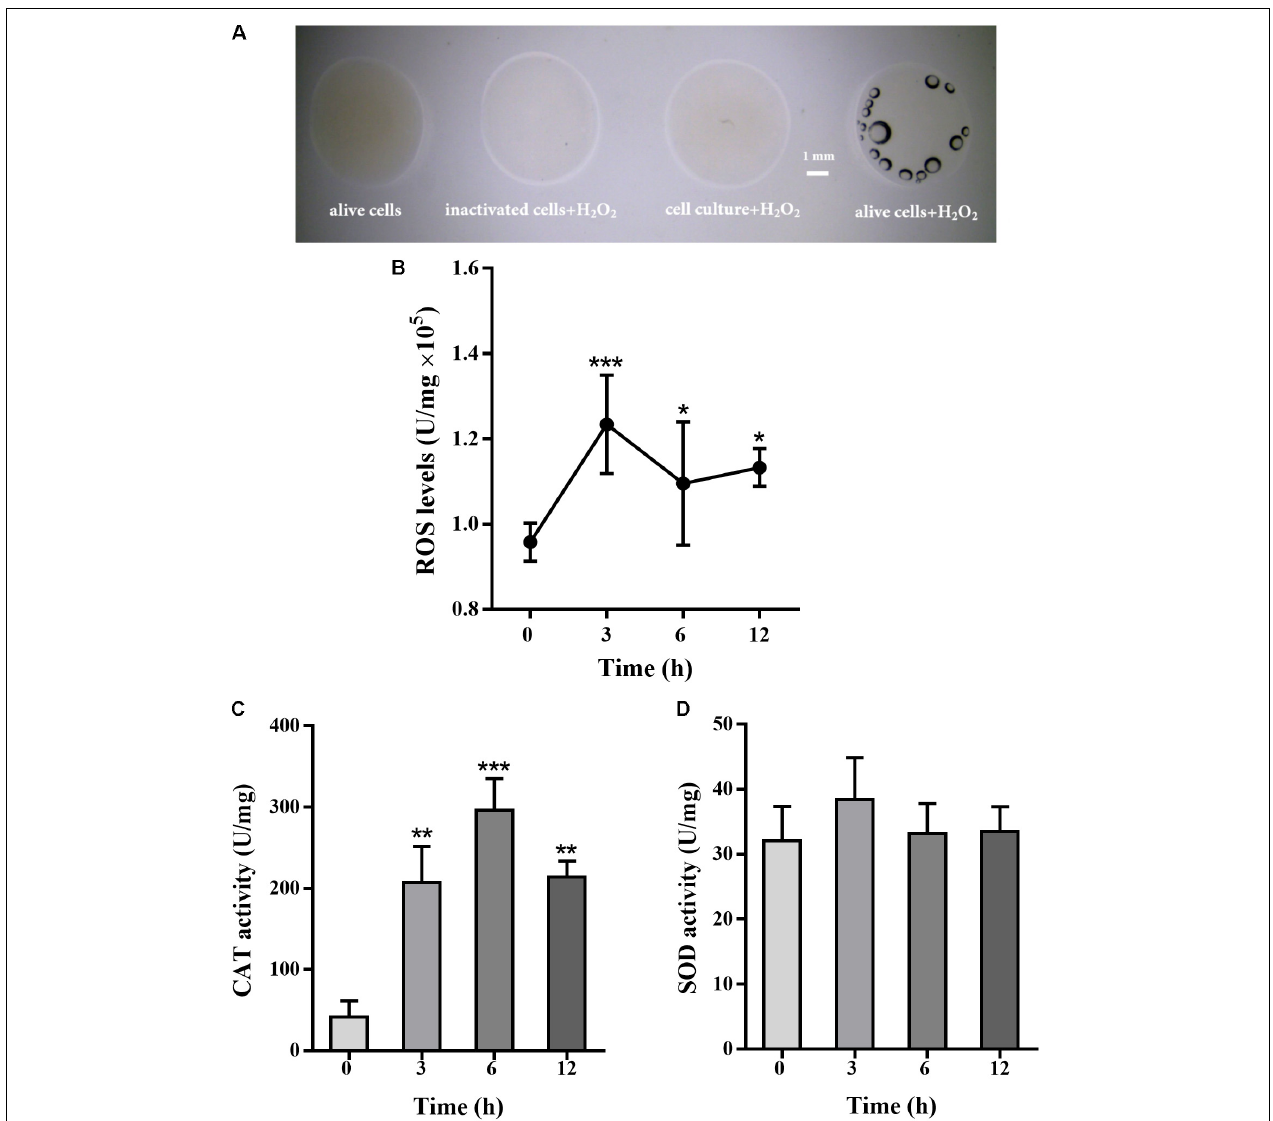
FIGURE 4 | Effect of H 2 O 2 on total cellular ROS levels, CAT and SOD activity in P. putida MnB1. H 2 O 2 (9.7 M) was added to cell suspension, and bubble formation was observed by Dissecting Microscope (scale bar, 1 mm) (A) . The volume of four reactions were 20 µ L, containing alive microbes (without H 2 O 2 ), 10 µ L cell culture after removing microbes and 10 µ L H 2 O 2 , 10 µ L inactivated bacteria with10 µ L H 2 O 2 , and 10 µ L alive microbes with 10 µ L H 2 O 2 (scale bar, 1 mm). Cellular total ROS levels were determined with 200 µ M H 2 O 2 incubation for 0, 3, 6, and 12 h ( n = 4), respectively (B) . Cellular activity of CAT (C) and SOD (D) was analyzed, respectively ( n = 4). Total ROS levels, CAT and SOD activity were calibrated to protein concentration in each sample. Data are expressed as mean ± SEM. Significance, ∗ P < 0.05, ∗∗ P < 0.01, and ∗∗∗ P < 0.001 vs. control group (0 h